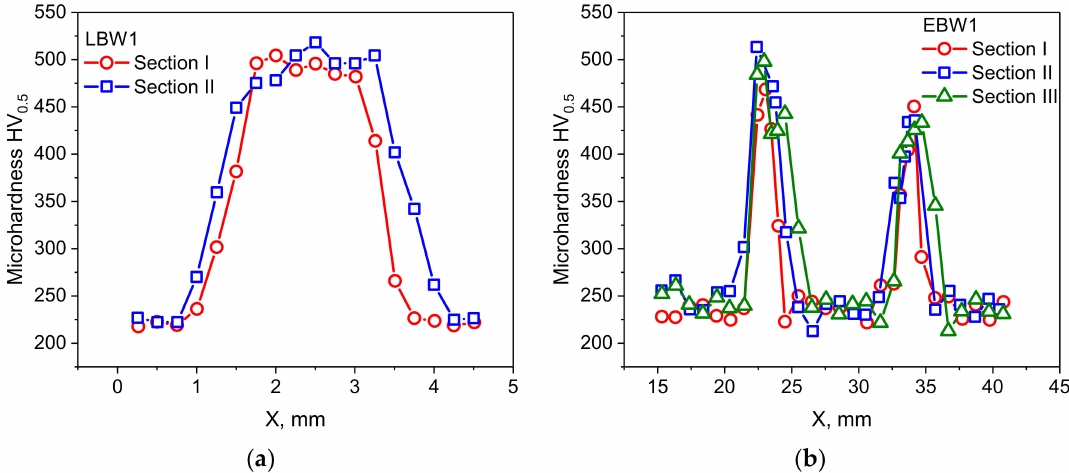
Figure 9. Microhardness distributions for EBW1 ( a ) and LBW1 ( b ) specimens along the weld depth. Section I-8 mm from top surface, Section II-5 mm from top surface, Section III-2 mm from top